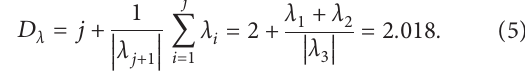
Table 1: Various phase portraits of system (1) for some fixed parameters (PVs parameter values, PPs phase portraits, and Ps Poincare